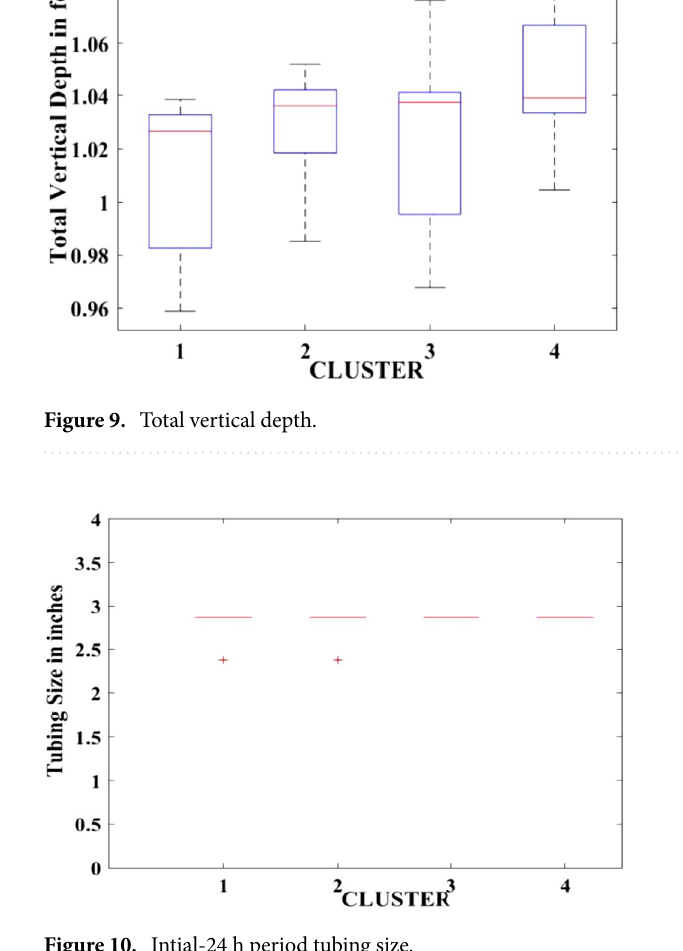
Figure 10. Intial-24 h period tubing size.